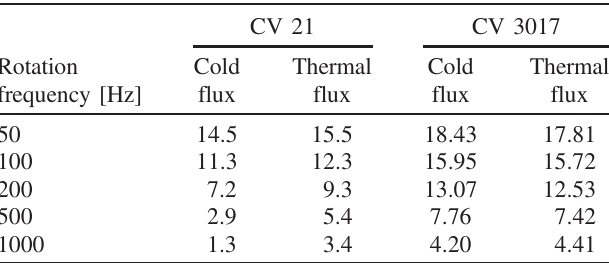
TABLE IV. Difference in % between the maximum and minimum neutron flux in the two control volumes (CV) with different rotation frequencies.